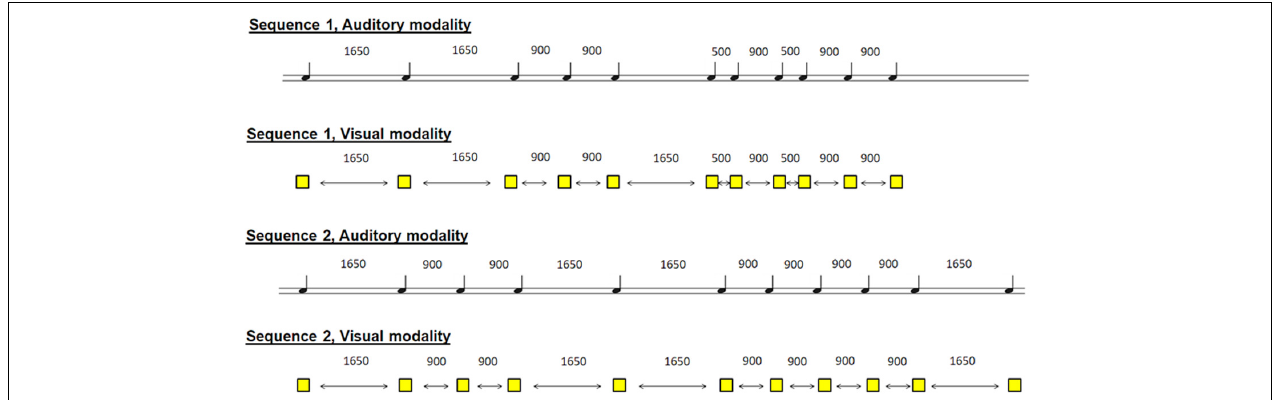
FIGURE 1 | Schematic representation of the 4 sequences. 2 sequences in the auditory modality and 2 sequences in the visual modality. The participant had to learn one sequence in one modality and the other sequence in the other modality. Sequences and modalities were presented randomly among participants.